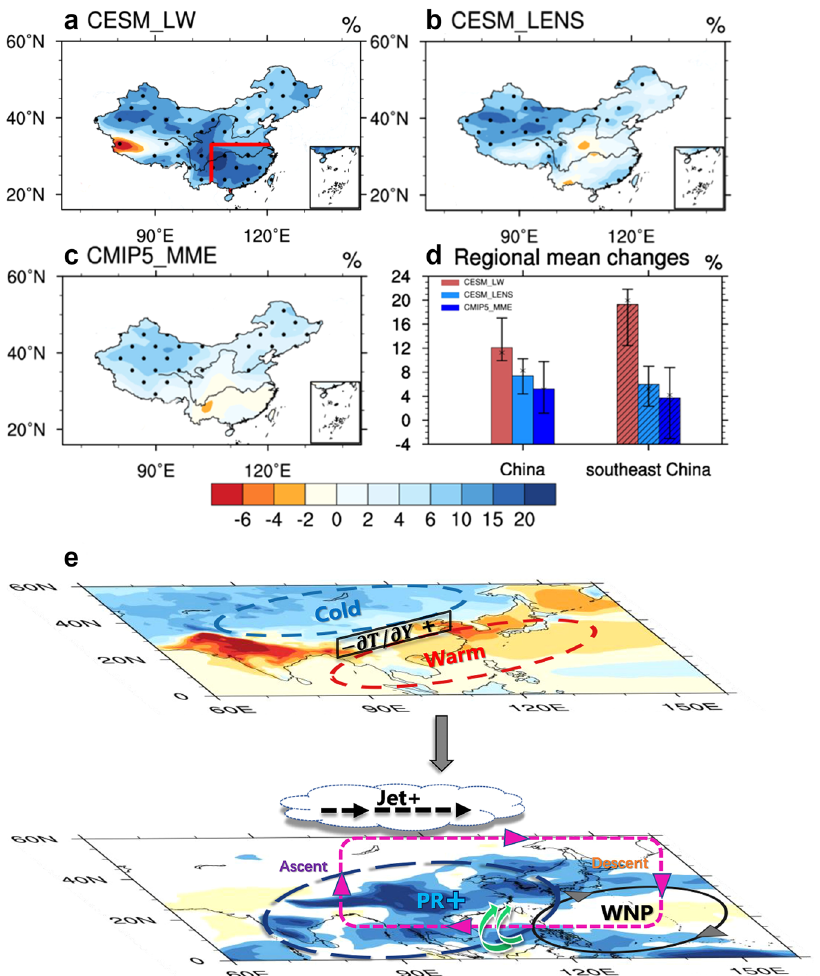
Fig. 7 The signi fi cant differences of precipitation at GW1.5 for the whole of China and especially for Southeast China under the transient scenario and stabilized scenario. Relative changes of summer (JJA) precipitation (relative to 1986 – 2005, considered as present-day climate) at GW1.5 (relative to preindustrial), obtained with a CESM low-warming simulations (noted as CESM_LW, stabilized scenario), b CESM large- ensemble simulations (noted as CESM_LENS, transient scenario), and c CMIP5 models in their ensemble-mean form (noted as CMIP5_MME, transient scenario). The red box indicates south-eastern China (target domain 22 – 33°N, 105 – 122°E, land areas). d Percentage change in regional mean precipitation in China versus south-eastern China. Error bars denote the range of the ensemble members, and the bar heights are the median of the ensemble. e Schematic diagram showing mechanisms that increase JJA total precipitation over south-eastern China at GW1.5 under a stabilized warming scenario compared to a transient scenario. Red (blue) contours indicate positive (negative) surface temperature anomalies. Purple and black dotted arrows represent the enhanced Walker circulation and westerly jet, respectively. Green curved arrows represent moisture transport. The solid circle with arrows represents the anticyclone over the western North Paci fi c (WNPSH). This fi gure is adapted from Figs. 1 and 10 of Jiang et al.